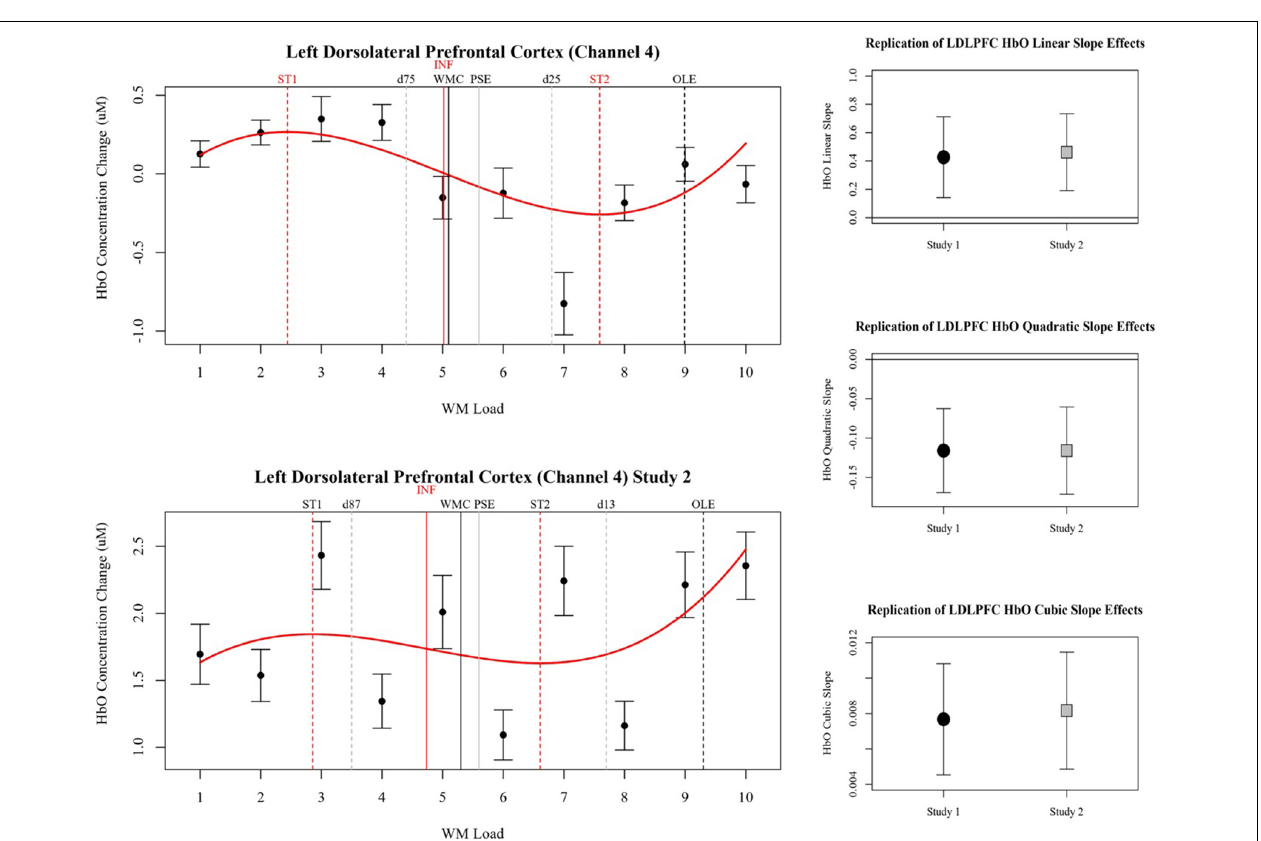
FIGURE 6 | Left plots show relative concentration changes in HbO as a function of working memory load in the LDLPFC (Channel 4). Annotated from the behavioral models are the estimates of working memory capacity (WMC and PSE) as well as bounding estimates of optimal workload ( d ). HbO estimates of WMC (INF) and bounding estimates of optimal load are also annotated (ST1, ST2). Study 1 is depicted in the top left, and study 2 is depicted in the bottom left. On the right, Beta coefficients and 95% confidence intervals of LDLPFC HbO linear, quadratic, and cubic slopes in study 1 and study 2 are